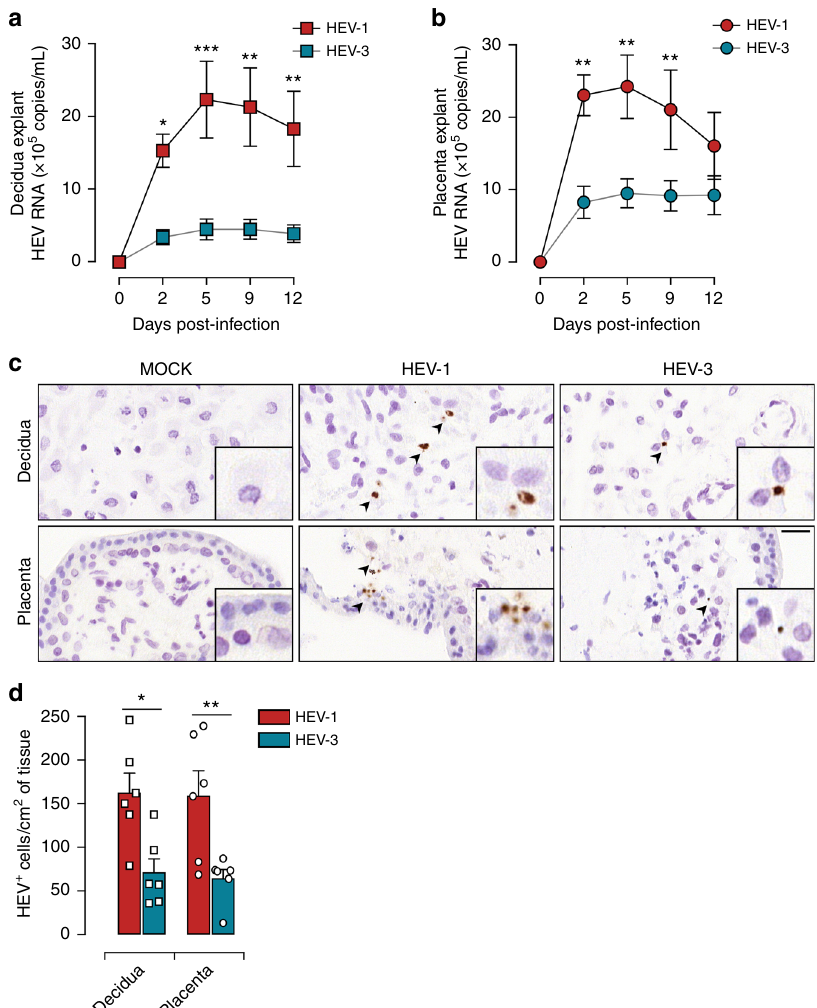
Fig. 1 HEV-1 replicates ef fi ciently in decidual and placental tissues. a , b Kinetics of HEV virus production from explants established from the decidua a and placenta b , infected with HEV-1 (red), or HEV-3 (cyan). RNA levels were measured in tissue culture supernatants by RT-qPCR. c , d Histological analyses of tissue sections stained by HEV in situ hybridization (ISH) and prepared from mock, HEV-1, or HEV-3 infected explants 5 days post infection. c Representative fi eld of view of explant material derived from the decidua (upper panel) and placenta (lower panel). Arrowheads point to HEV positive cells (in brown) and boxes represent enlarged areas with characteristic staining patterns. Scale bar, 20 µ m. d Bar graph illustrating the number of HEV positive cells per cm 2 of tissue determined by ISH staining in HEV-1 (red) or HEV-3 (cyan) infected tissue explants. Data represent mean values ± S.E.M. of six independent donors. * denotes a statistical comparison between HEV-1 and HEV-3 infected tissues. * P < 0.05; ** P < 0.01; *** P < 0.001 by